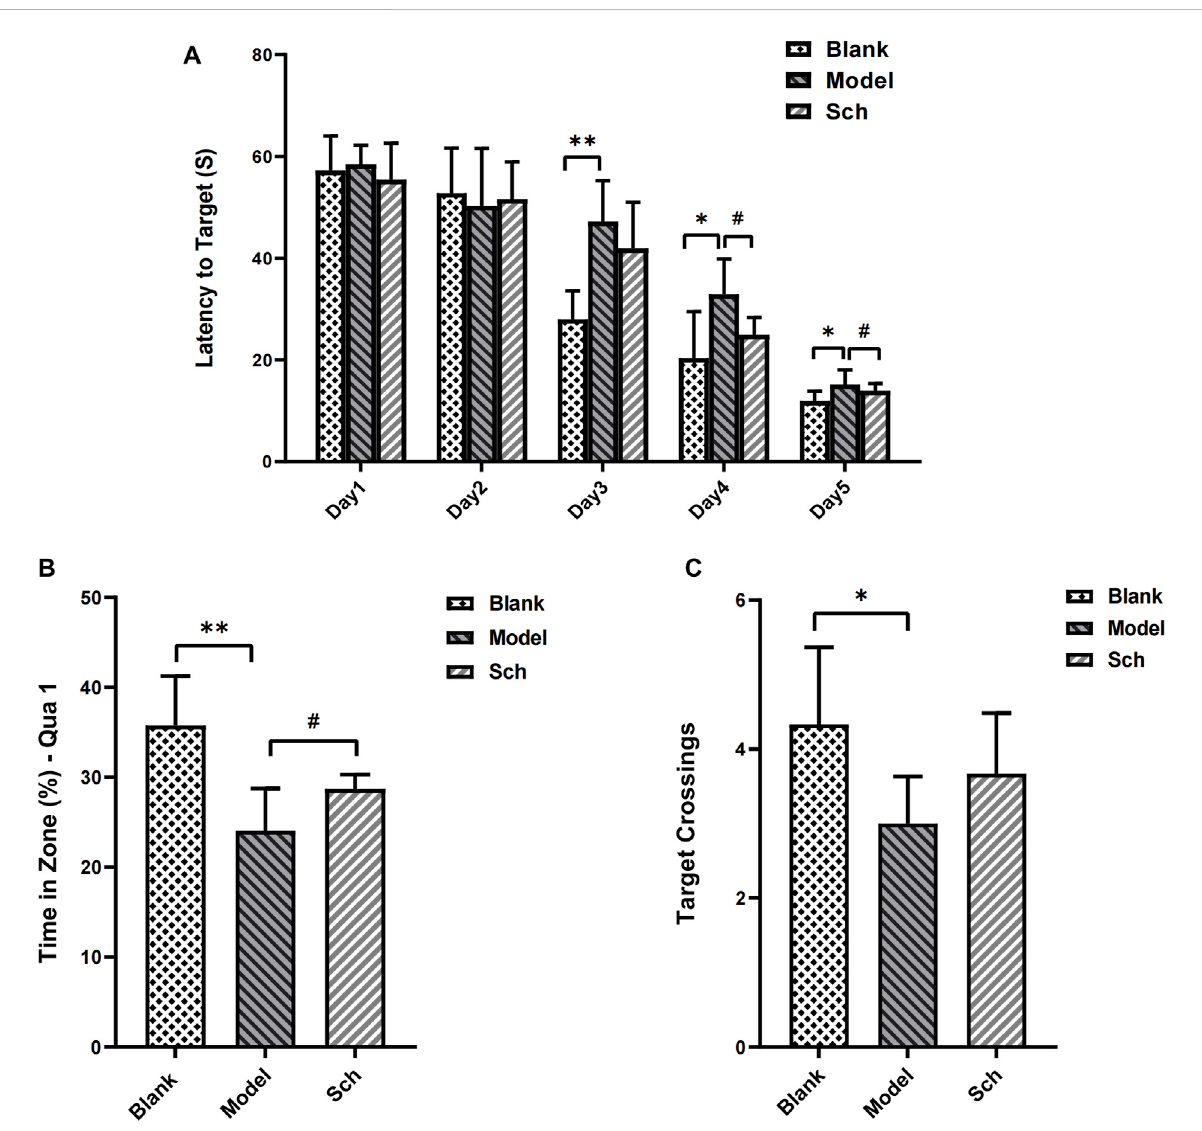
FIGURE 1 Effects of schisandrin on the cognitive impairment of rats with AD in the MWM test. (A) Escape latency of rats in the space exploration experiment; (B) time percentage of the rats stayed in the target quadrant in spatial exploration test; and (C) number of times the rats crossed